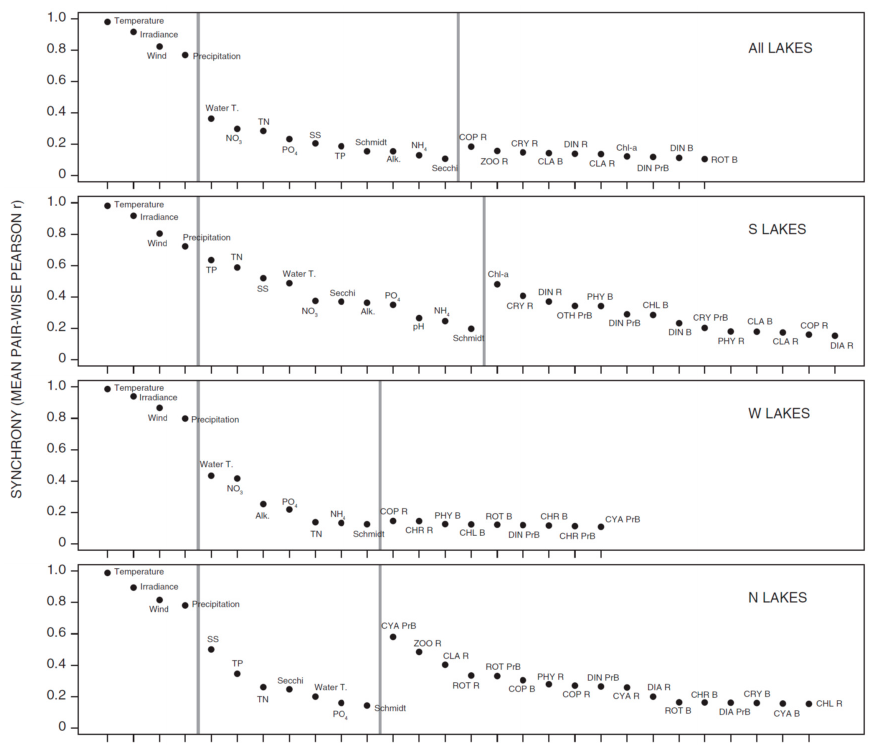
Figure A2. Summary of synchrony in climate, lake and plankton variables in spring analysed for all lakes and for S, W and N lakes separately. For details see Figure 3.